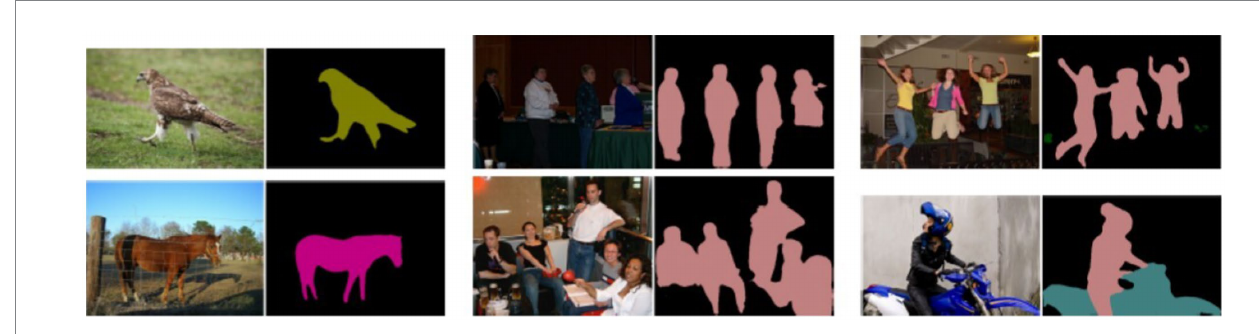
FIGURE 3 Examples of segmentation results through CNNs from Chen et al. (2017). Reprinted with